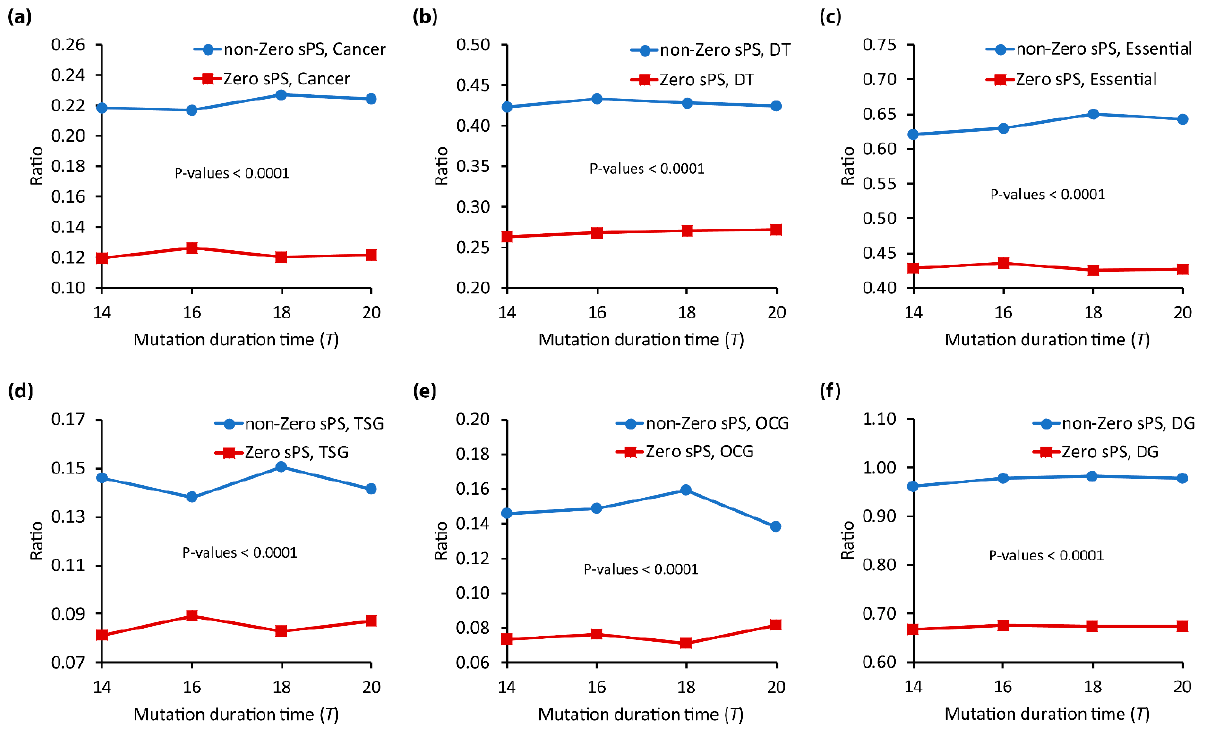
Figure 3. Relation of 𝑠𝑃𝑆 with the functionally important genes in KEGG network. ( a–f ) Results of cancer genes, drug targets, essential genes, tumor suppressors, oncogenes, and disease genes, respectively. In each subfigure, all genes were classified into ‘non-zero 𝑠𝑃𝑆 ’ and ‘zero- 𝑠𝑃𝑆 ’ groups. Y -axis is the ratio of the functionally important genes among the total genes in the group. The mutation duration time 𝑇 was varied from 14 to 20.